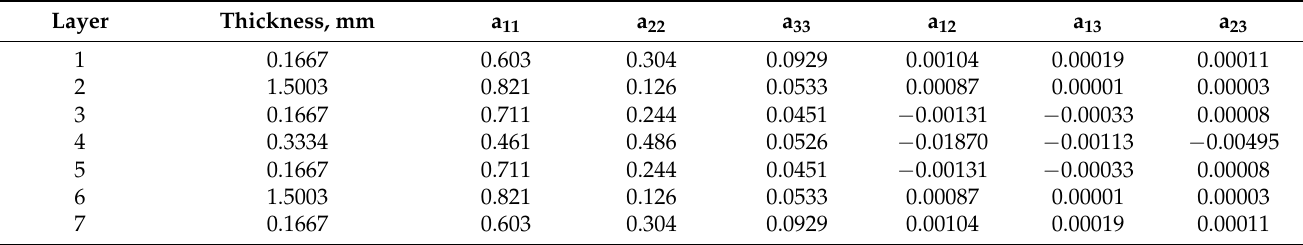
Table 1. Calculated fiber orientation tensor